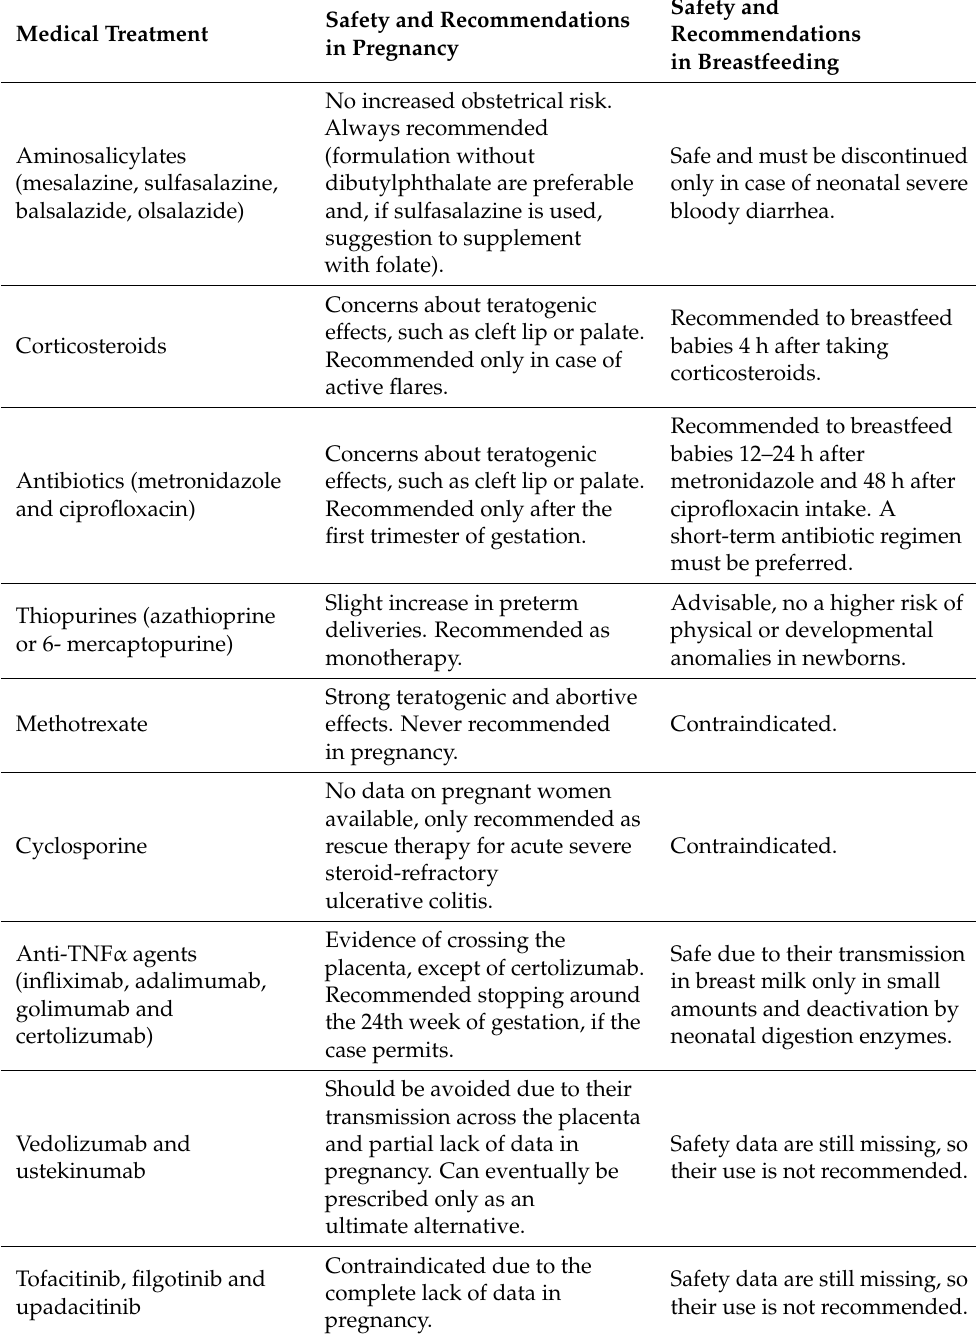
Table 1. Drug safety and recommendations in pregnancy and